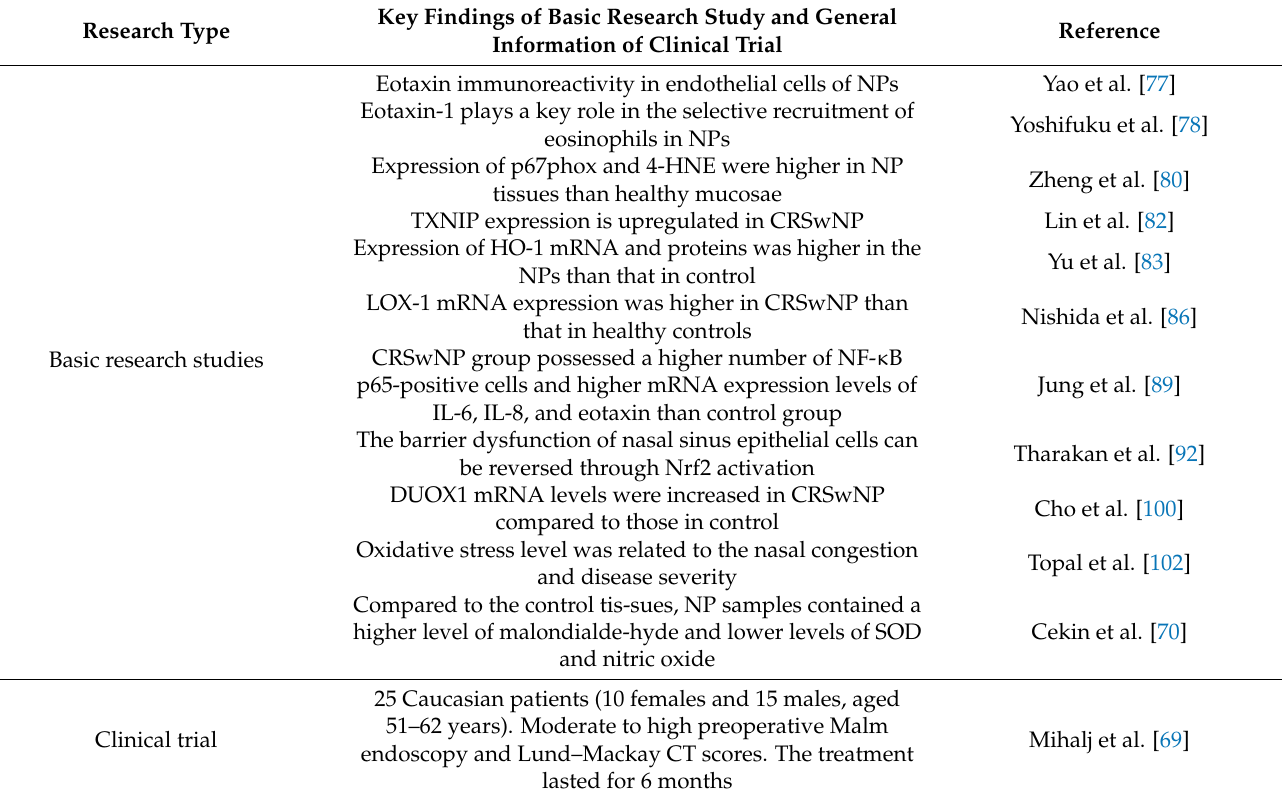
Table 3. Summary of studies of oxidative stress and antioxidants related to